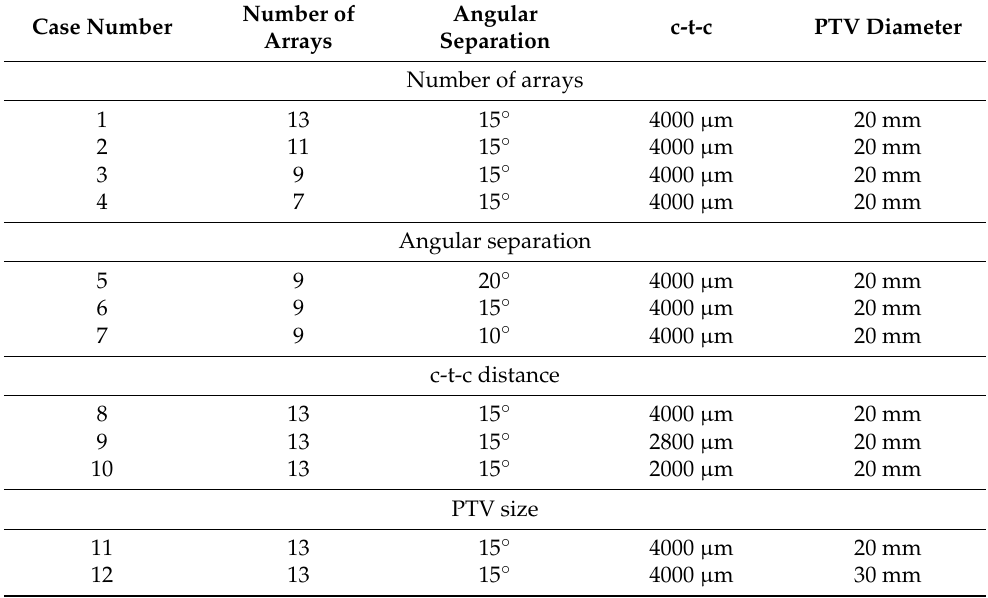
Table 1. pMBAT plans